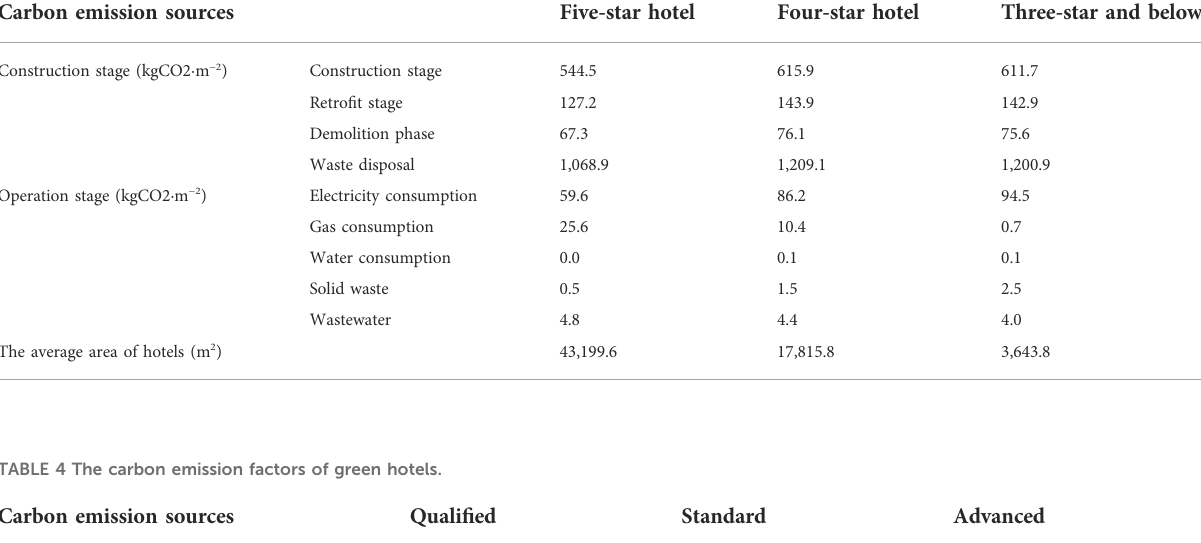
TABLE 3 The carbon emission factors of traditional hotels.